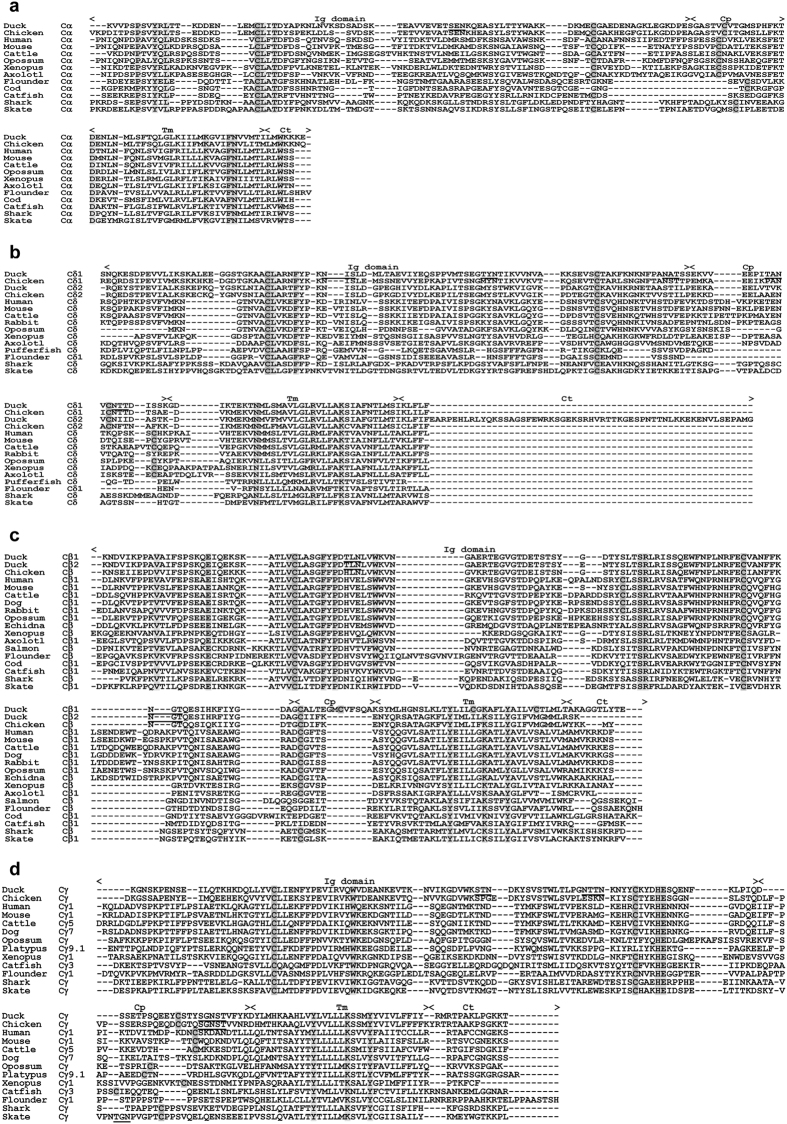
Alignment of deduced amino acid sequences of TCR C regions in selected vertebrates, Cα (a), Cδ (b), Cβ (c) and Cγ (d). The different domains of the C region are indicated above the sequences. Dashes indicate gaps. Canonical amino acids are shaded, and the potential N-linked glycosylation sites are underlined.